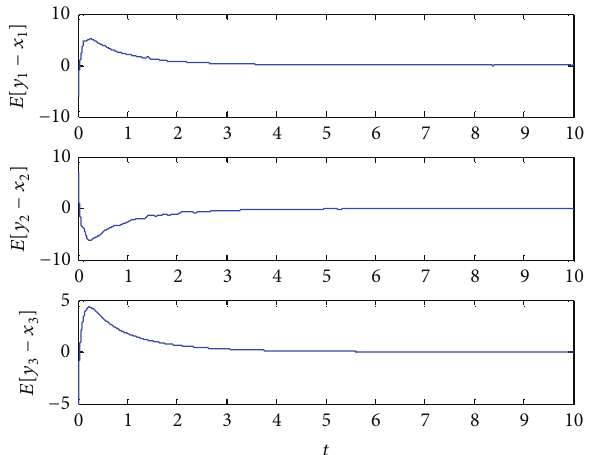
Figure 3: Mean value of synchronization errors 𝑒 1 , 𝑒 2 , 𝑒 3 between system (26) and system (31) using sliding mode method.